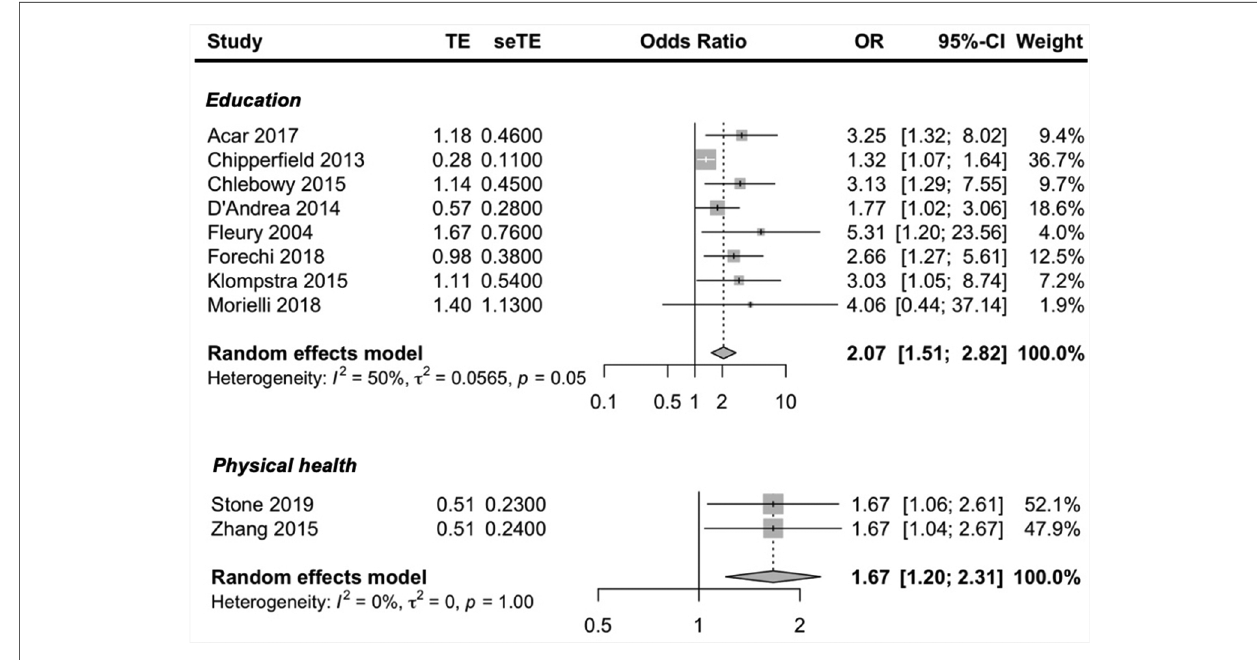
FIGURE 3 Forest plot social-economic